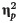
Effect size (ηp2) of statistical comparison (t-contrast) of control (CON) vs. distraction (DIS), CON vs. hypnosis (HYP), and CON vs. simulation (SIM) for processing of target stimulus.The comparisons of DIS vs. SIM and HYP vs. SIM were not significant. (A) The cortical mesh images show sources that were significantly less activated in HYP, DIS and SIM compared to CON following processing of target. PCu = precuneous; PrG = precentral gyrus; OFG = occipital fusiform gyrus. The summary statistic images of the cortical mesh were thresholded at uncorrected p = .001 with FWE correction at cluster-level, p = .0045 (one-sided, Bonferroni), based on random field theory. r = right, l = left. (B) The grandaverage cluster source waveforms (across subjects, n = 48) are based on the average of source waveforms within the respective clusters found in Fig 5A (CON > SIM) for the three Stimulus-Types in CON (black), HYP (red), DIS (grey), and SIM (blue). Source strength is expressed as root mean square (RMS, in arbitrary units). Grey rectangle marks the P3b window (320–470 ms).